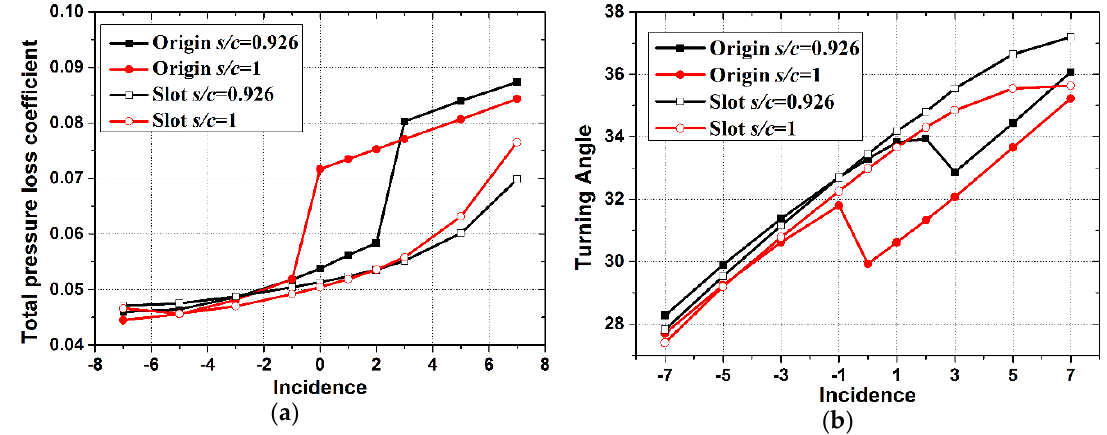
Figure 5. Influence of pitch ‐ chord ratio for different incidence angles on: ( a ) total pressure loss coefficient; and ( b ) flow turning angle.